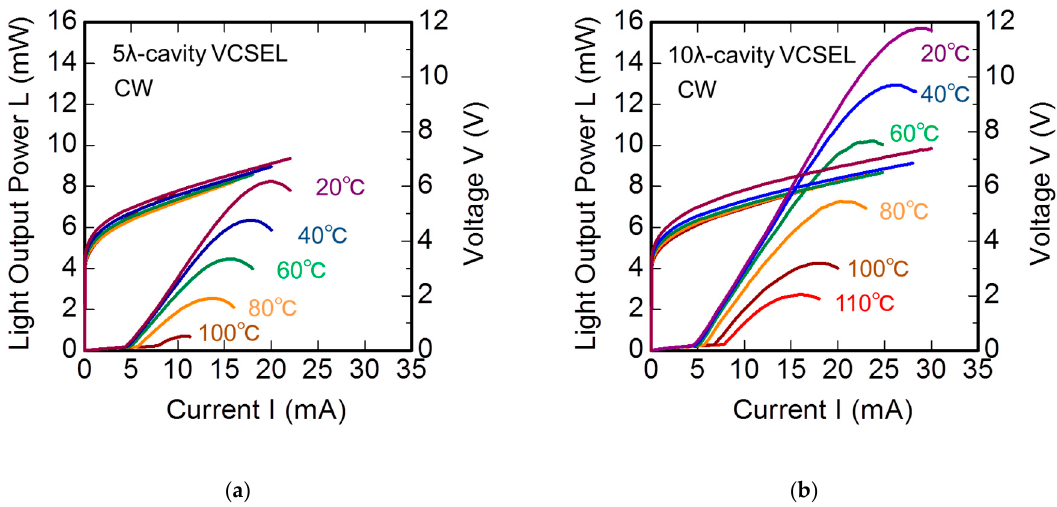
Figure 6. ( a ) I-L/I-V characteristics of the VCSEL having a 5- λ cavity structure over a temperature range from 20 to 100 °C. ( b ) I-L/I-V characteristics of the VCSEL having a 10- λ cavity structure over the temperature range from 20 to 110